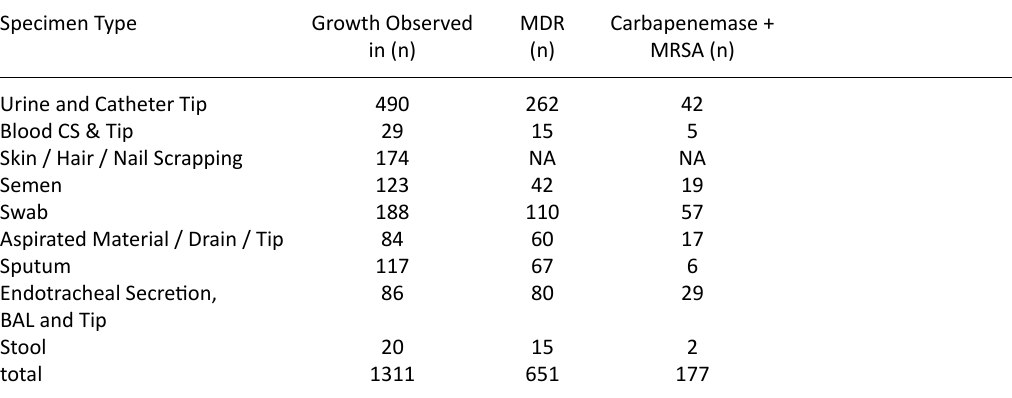
table 1. Isolate wise distribution of multidrug resistant strains from various clinical specimen Specimen